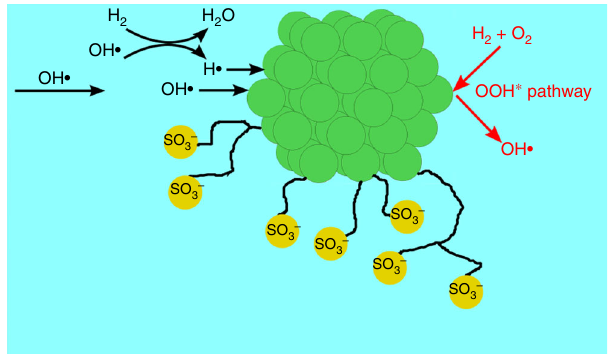
Fig. 5 Schematic of the interaction of the embedded nanoparticles with radicals in solution. Green circles represent atoms of the embedded nanoparticle, and yellow circles represent sulfonic groups of the Na fi on that are susceptible to The measured PEMFC membranes were further analyzed using cross-sectional SEM images (Supplementary Fig. 12) and FIB-SEM to reveal the detailed 3D microstructure. Figure 4a shows a PEM sample during FIB-SEM tomography in which the milled region is identi fi ed. Figure 4b – f present the 3D morphology of fresh and used membranes reconstructed from